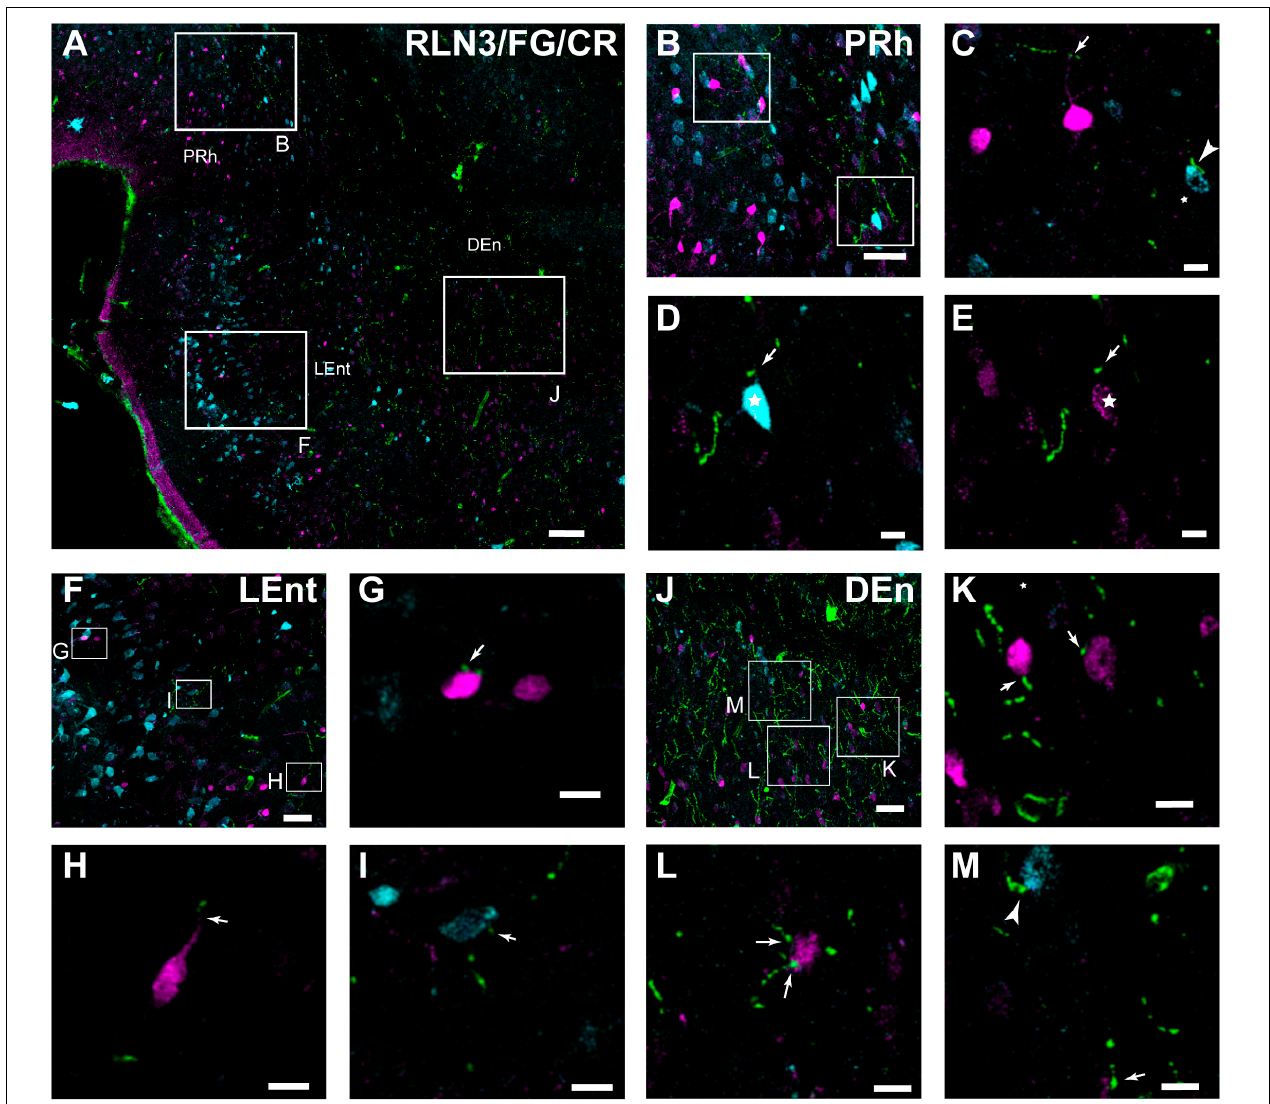
FIGURE 10 | Close contacts in the lateral aspects of the parahippocampal cortex between RLN3 fibers (green channel) and CR-positive neurons (magenta channel) or neurons retrogradely-labeled (cyan channel) by FG injections into the hippocampal CA1 field. (A) Overview of an overlay of 10 µ m z-stacks in the lateral entorhinal and perirhinal cortices. Calibration bar 100 µ m. (B) Labeling in a single 1 µ m section of the deep layers of the perirhinal cortex. Calibration bar 40 µ m. (C–E) Higher magnification images of the inset in (B) , illustrating RLN3 fibers contacting CR processes (arrow) and retrograde FG labeling (arrowhead) of case FG34, in which the injection site was restricted to the DG. Calibration bars 20 µ m. (F) Labeling in the superficial layers of the LEnt. Calibration bar 50 µ m. (G–I) Higher magnification images of the boxed areas in (F) , illustrating (G,H) contacts with CR neurons and (I) FG labeled neurons. Calibration bars 20 µ m. (J) Labeling in the DEn. Calibration bar 50 µ m. (K–M) Higher magnification images of the boxed areas in (J) , illustrating (K,L) contacts with CR neurons and processes and (M) FG neurons. Calibration bars 20 µ